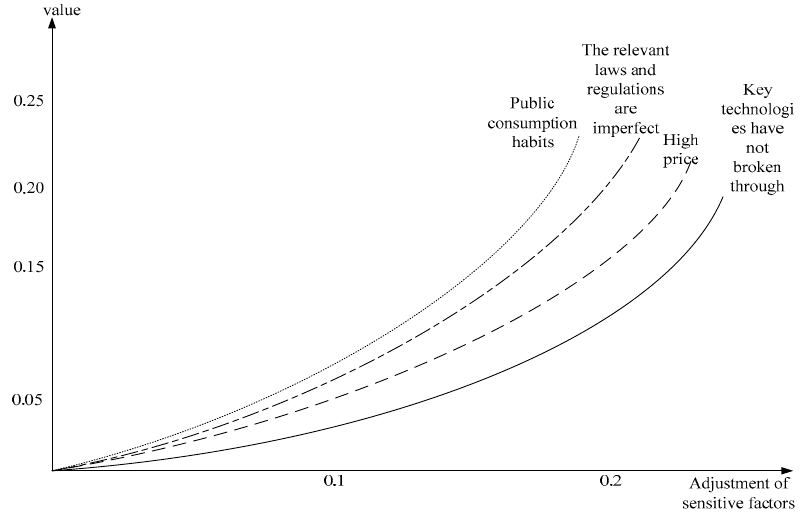
Figure 6. Risk level adjustment under sensitive factors.